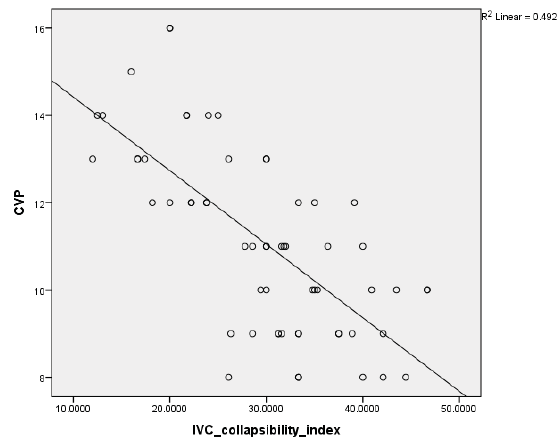
Figure 1. Pearson correlation between CVP and